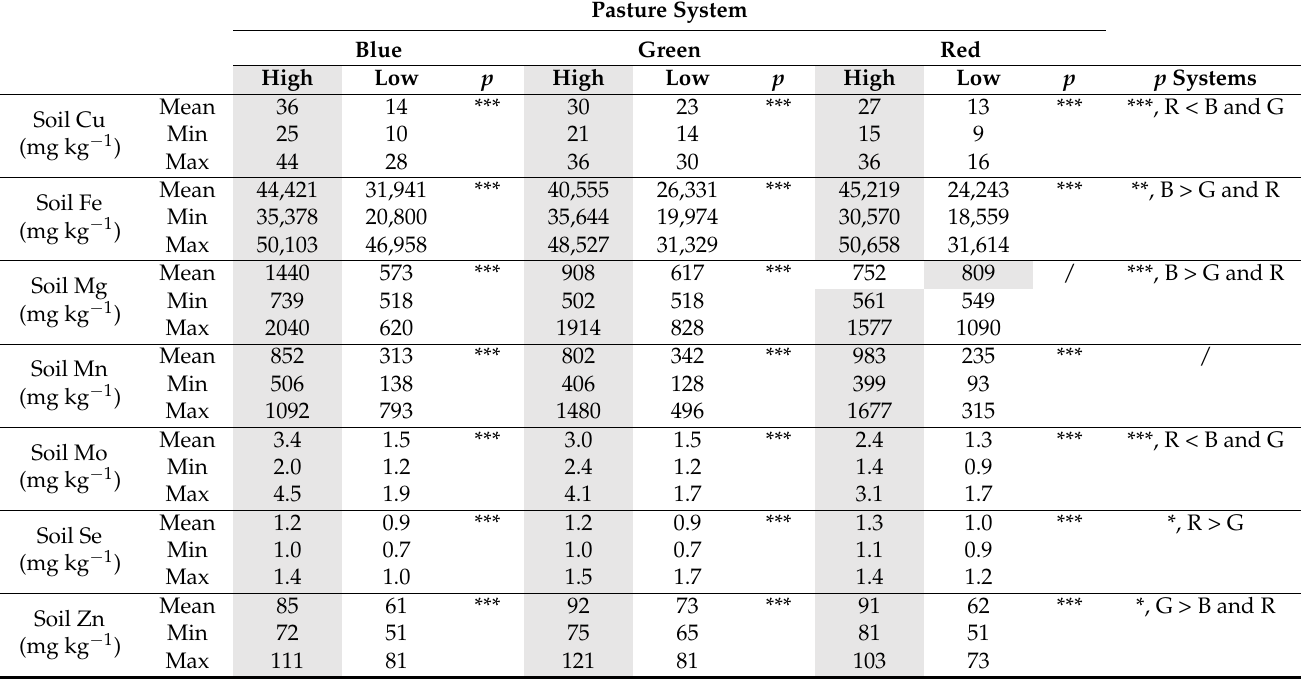
and green/P + N systems compared to the red/HSG + N system corresponded to a greater slope, elevation and SOM content. Table 1. Mean, minimum and maximum of soil total concentrations of micro-nutrients: Cu, Fe, Mg, Mn, Mo, Se and Zn at points selected as high or low soil total micro-nutrient content; 8 high and 8 low points in each of the pasture systems: high-sugar grass + legume mix − N fertilizer (blue/HSG + L), permanent pasture + N fertilizer (green/P + N), high- sugar grass + N fertilizer (red/HSG + N). p = significance between high and low sites and between systems: * = p <